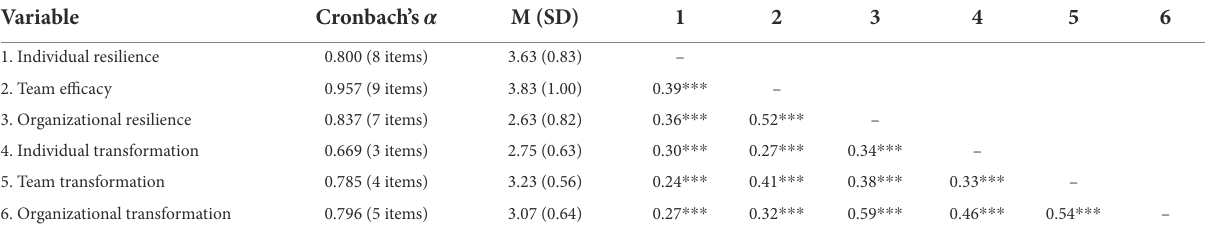
TABLE 1 Descriptive statistics and correlations of the measures.